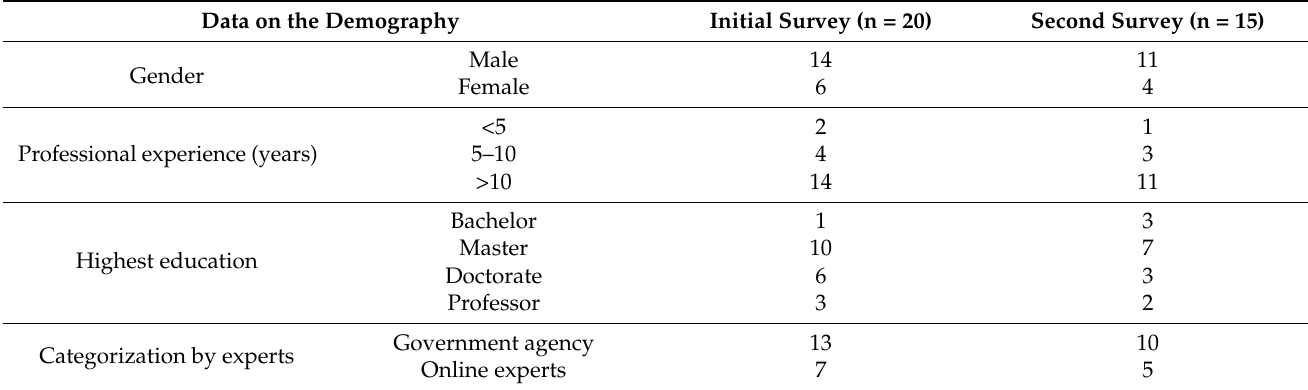
Table 1. Background of the expert panel participating in the DAHP model in terms of sociodemo-